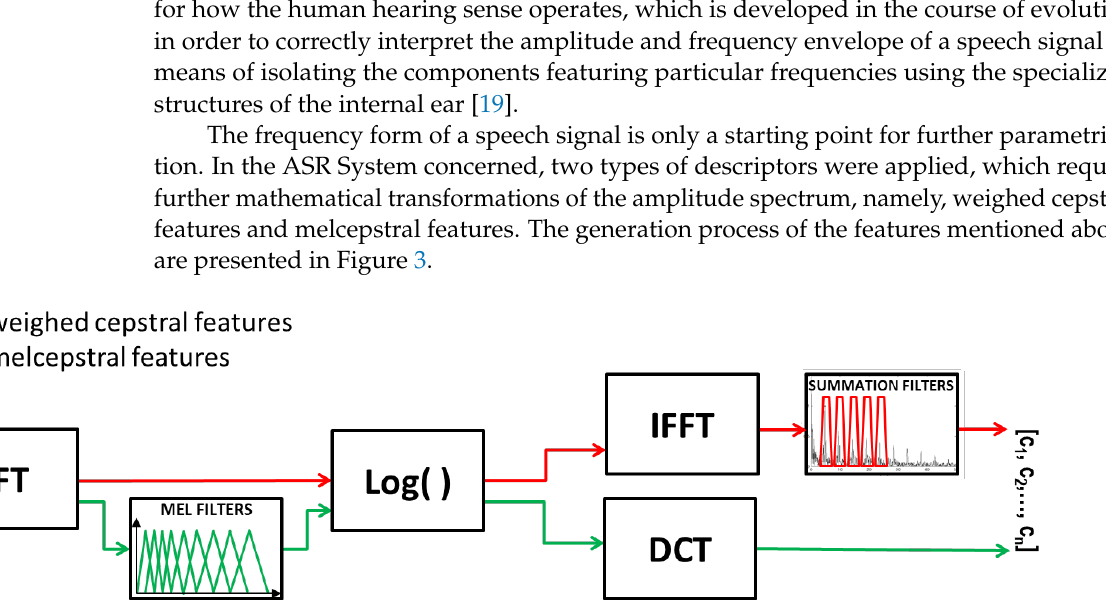
Figure 3. Diagram of generating distinctive features applied in the ASR System [17].